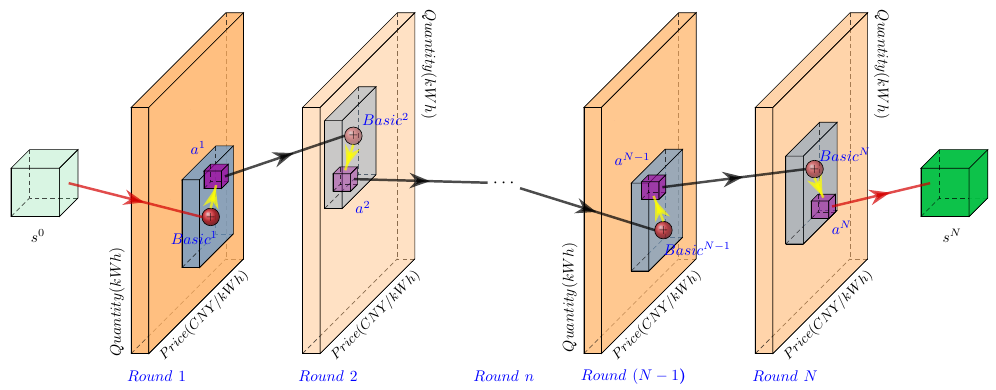
Figure 8. The update process of bidding action in the proposed Q-learning